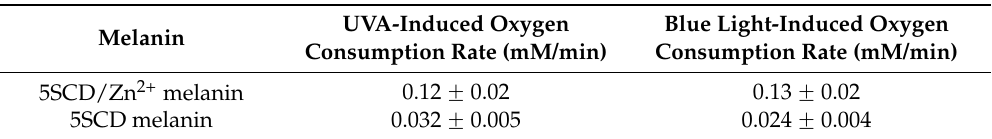
Table 2. Oxygen consumption rate by 5SCD melanins prepared in the presence or in the absence of Zn 2+ ions upon irradiation with UVA or blue light [52].